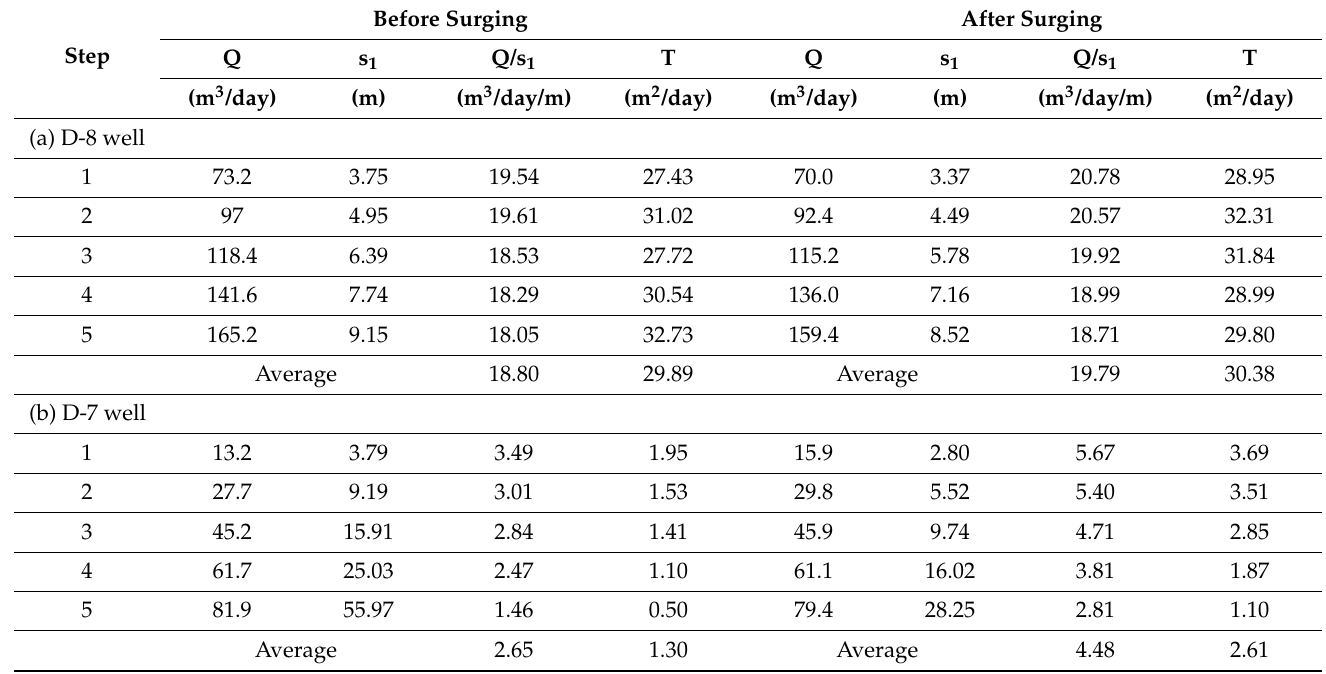
Table 2. Comparisons of specific discharges and transmissivities before and after air surging during each step in the D-8 and D-7